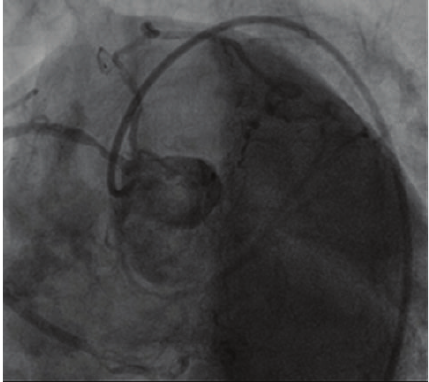
Figure 3: Severe coronary artery stenosis detected on cardiac angiography.